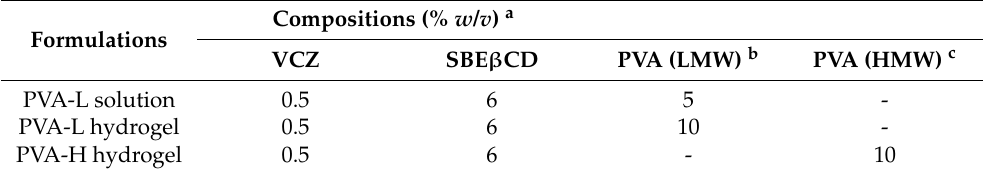
Table 9. Compositions of VCZ eye drop